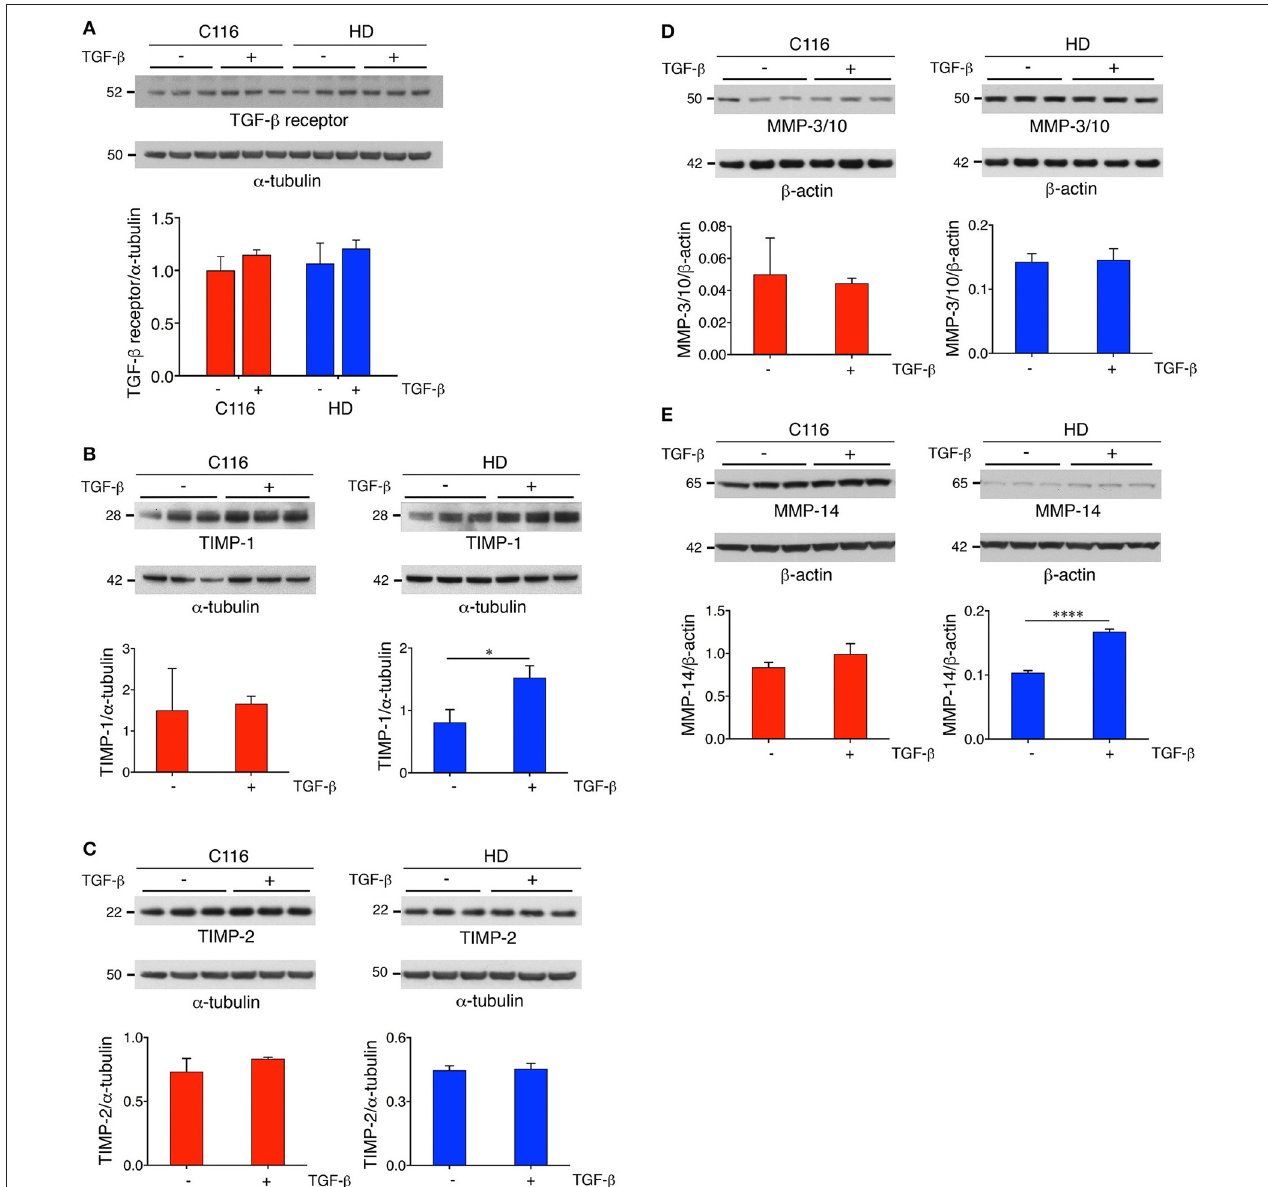
FIGURE 6 | TGF- β treatment regulates TIMP-1 expression. C116- and HD-NSCs were treated with 10ng/mL TGF- β for 24h. (A) Immunoblot analysis demonstrates that both corrected C116- and HD-NSCs express the TGF- β receptor at equal levels, and that exogenous TGF- β administration does not modulate expression of its cognate receptor (ANOVA with Tukey’s multiple comparison test). Western blot analysis reveals that TGF- β treatment resulted in increased expression of TIMP-1 in HD-NSCs (B) , but not in C116-NSCs. No changes are observed in the expression levels of TIMP-2 (C) and MMP-3/10 (D) in response to TGF- β , however, a very modest increase is observed in MMP-14 expression in HD-NSCs (E) (* p < 0.05; **** p < 0.0001; t -test). Error bars represent SD